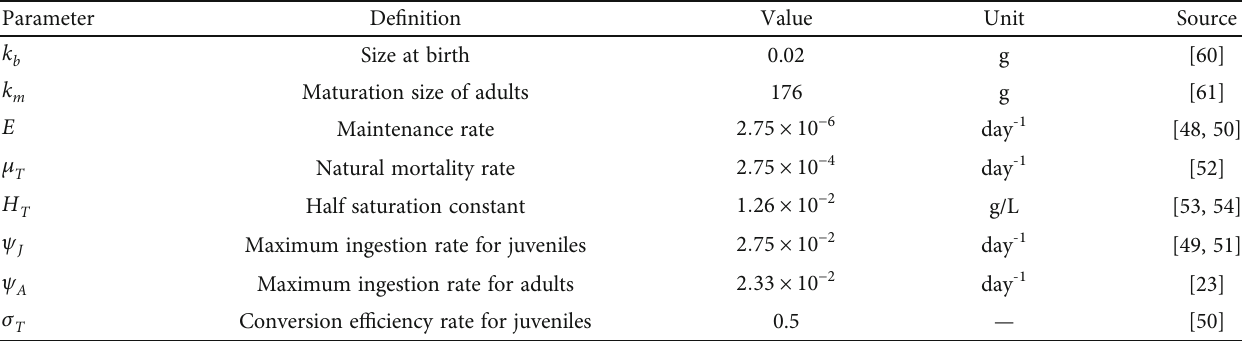
Table 4: Parameters for Nile tilapia, denoted Y in our model.